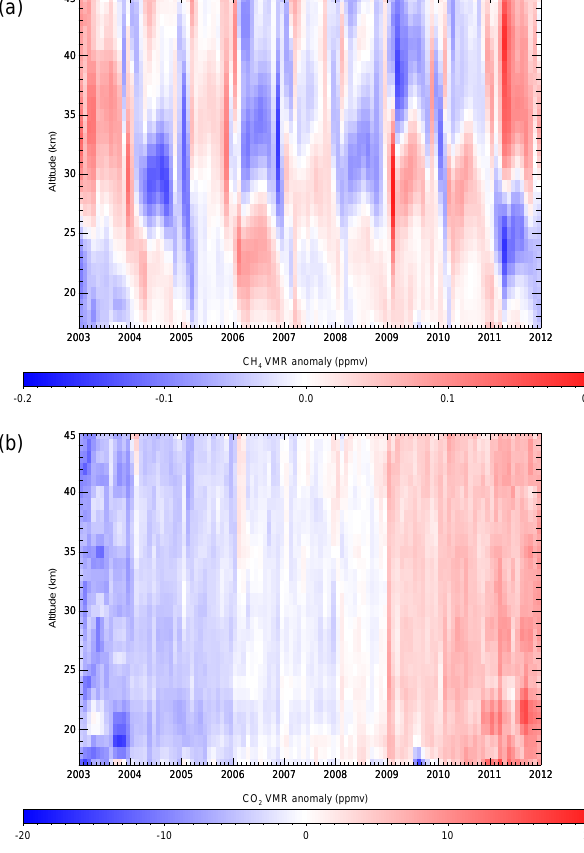
Figure 14. Time series of CH 4 (a) and CO 2 (b) monthly VMR anomaly profiles January 2003–December